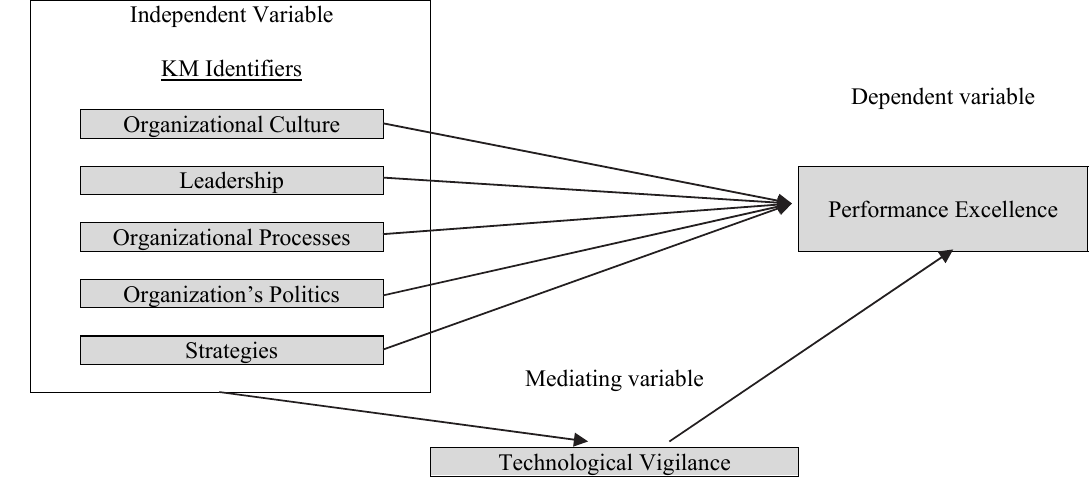
Fig. 1. Study Model adapted from Chang and Lin (2015) and Arumugam and Rouhollah